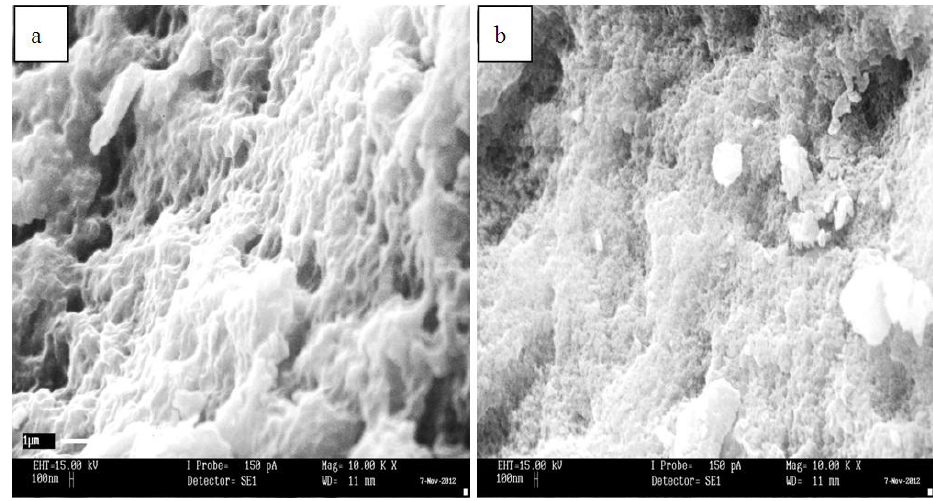
Figure 3. SEM micrographs of ( a ) methacrylic acid (MAA)- β CD molecularly imprinted polymer (MIP) and ( b ) MAA- β CD non-imprinted polymer (NIP) adsorbents. Reproduced with permission from [109], Copyright 2014, MDPI AG.